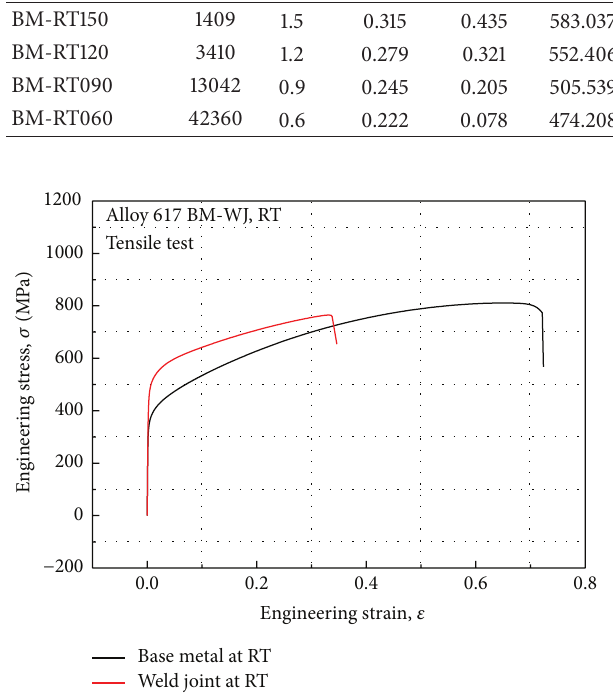
Figure 3: Stress-strain curves for Alloy 617 BM and Alloy 617 WJ in tensile tests at RT condition with a strain rate of 5.85 × 10 −4